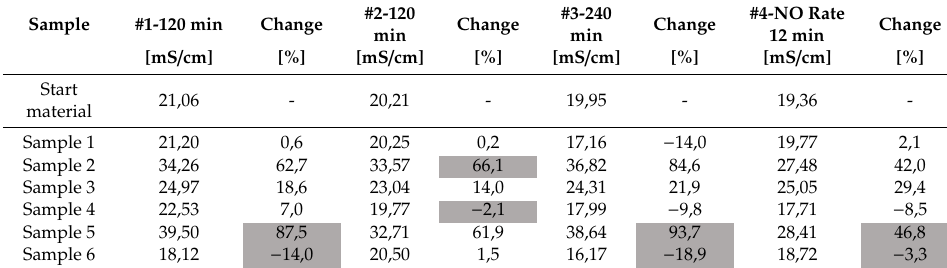
Table 3. Changes in conductivity measured by impedance spectroscopy. Higher conductivity reflects higher number of ions in the liquid sample. Gray marking highlights the most prominent changes in